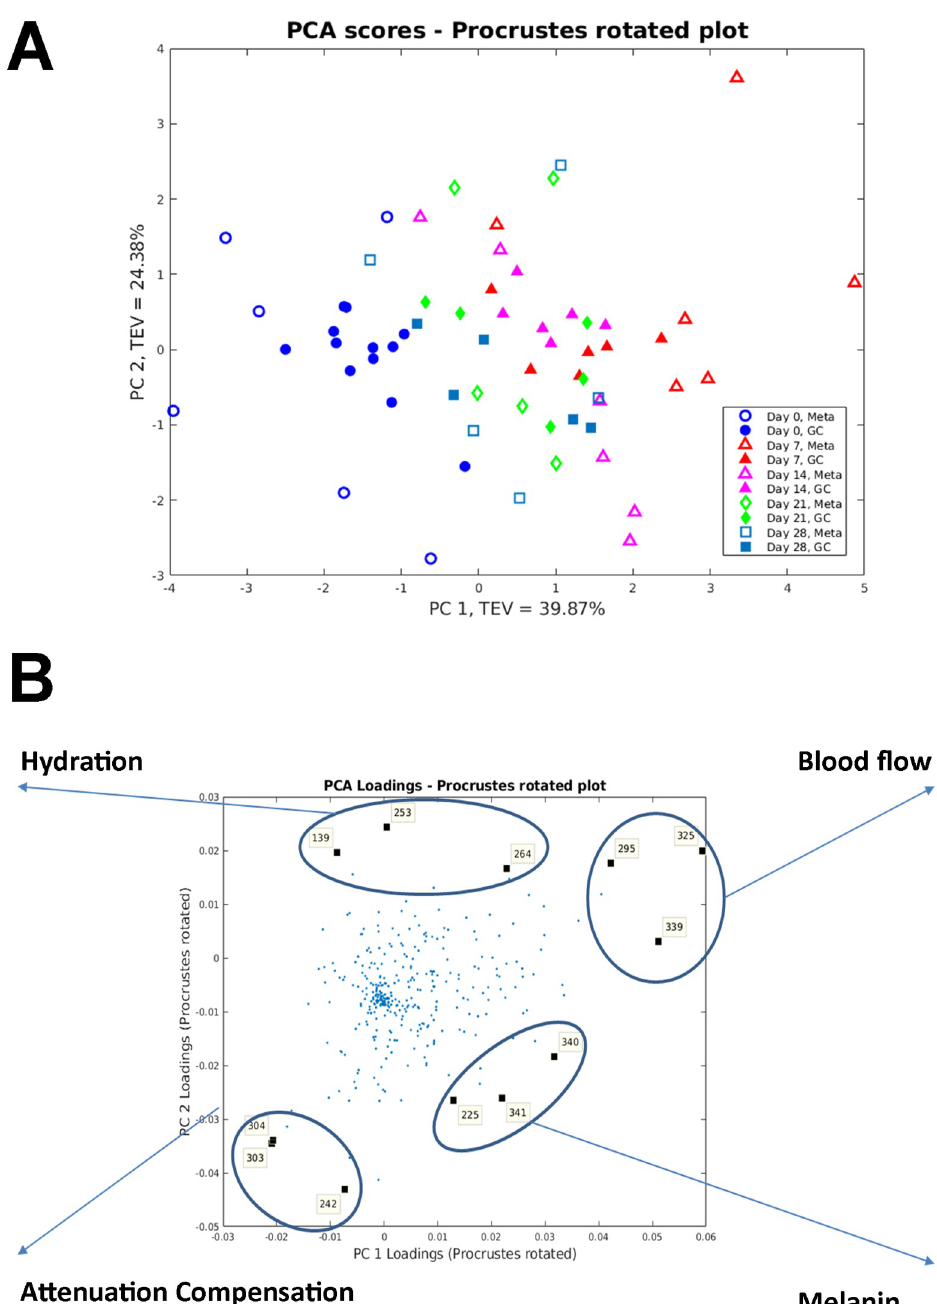
Fig 7. Procrustes analysis of non-invasive measures and wound tissue metabolome. (A) Procrustes rotated plot with a Procrustes distance of 0.6817; P < 0.001. (B) Procrustes rotated loadings plot highlighting metabolites mostly correlated to the non-invasive measures. 139–1-methyladenosine; 225—linolenic acid; 242—D-(+)-galactose; 253— myo-inositol; 264 –xanthine; 295—linolenic acid; 303 and 304—unknown; 325 and 339—glycerol; 340—shikimic acid;